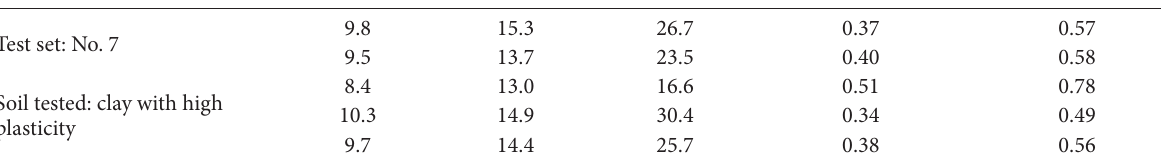
table 3. Average values of ratios obtained from Table 2